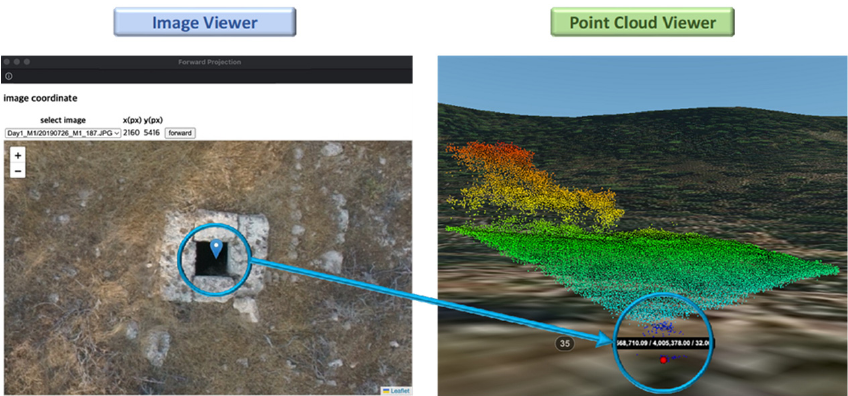
Figure 28. Illustration of the forward projection of a cistern image point (blue placemark) and its corresponding point in the LiDAR data (red dot).